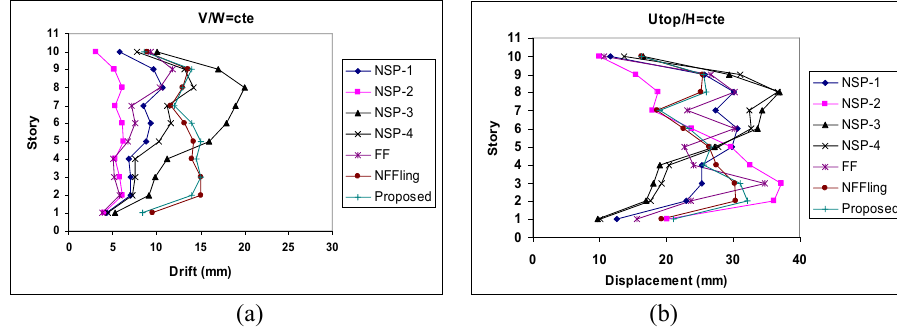
Figure 13. Inter-storey drift for 10-storey building with (a) V/W=cte, (b) U top /H = cte.